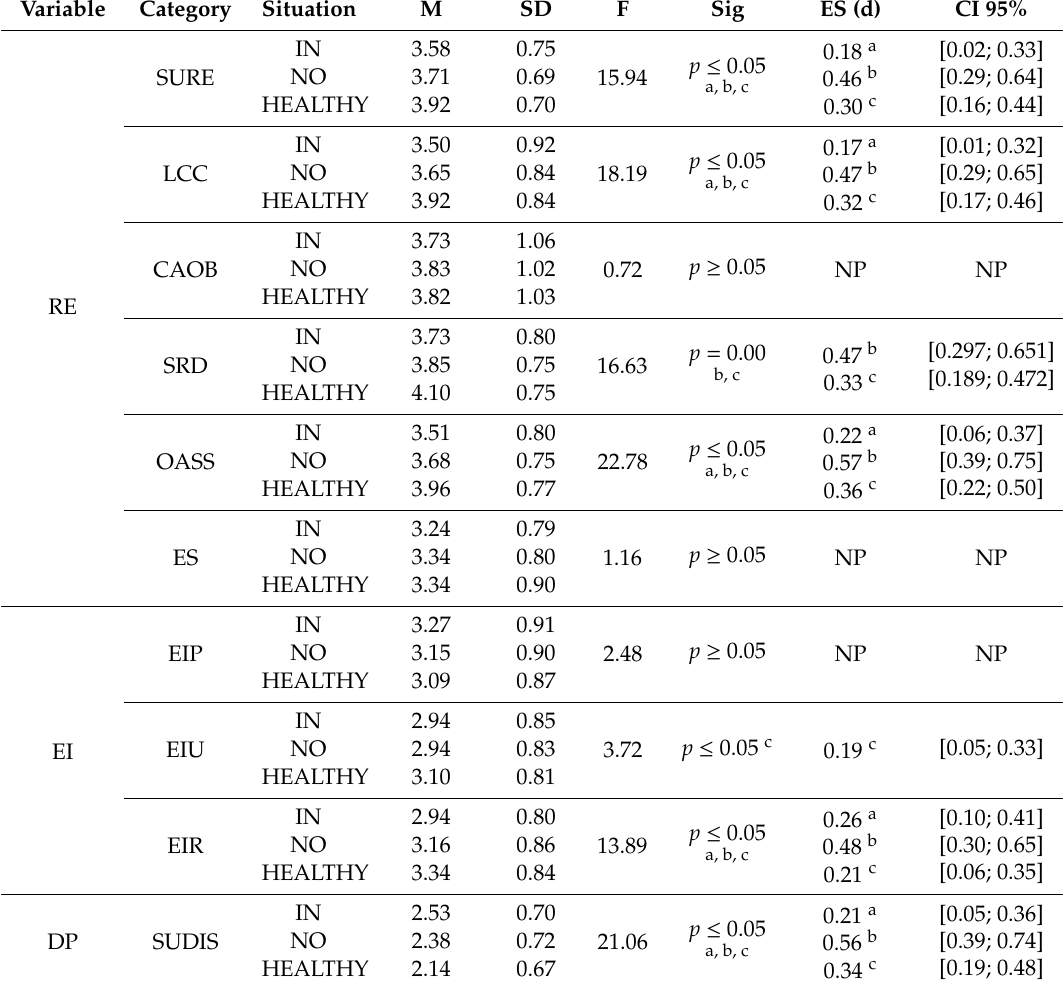
Table 2. Relationships between the dimensions of resilience, emotional intelligence, and psychological distress, as a function of physical activity su ffi ciency (inactive, below beneficial physical activity, and beneficial physical